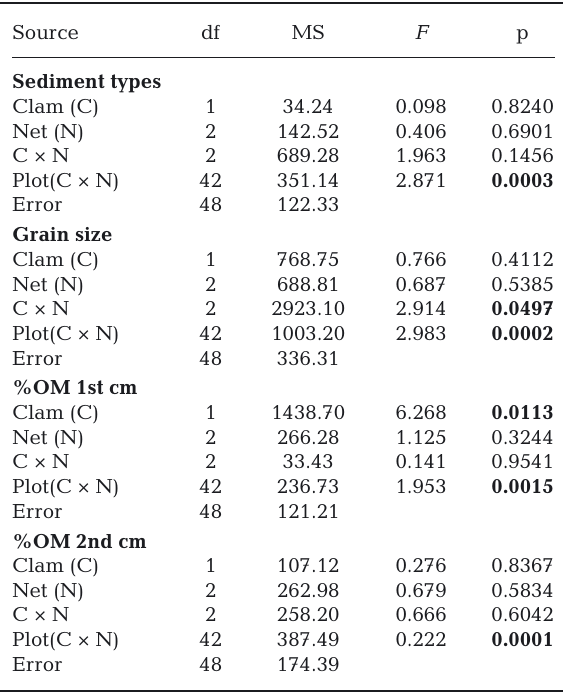
Table 1. Results of PERMANOVAs evaluating the effect of Clam (presence/absence), Net status (fouled, cleaned, or absent), and Plot (replicate plots for same treatment) on various sediment characteristics: sediment types, grain size,